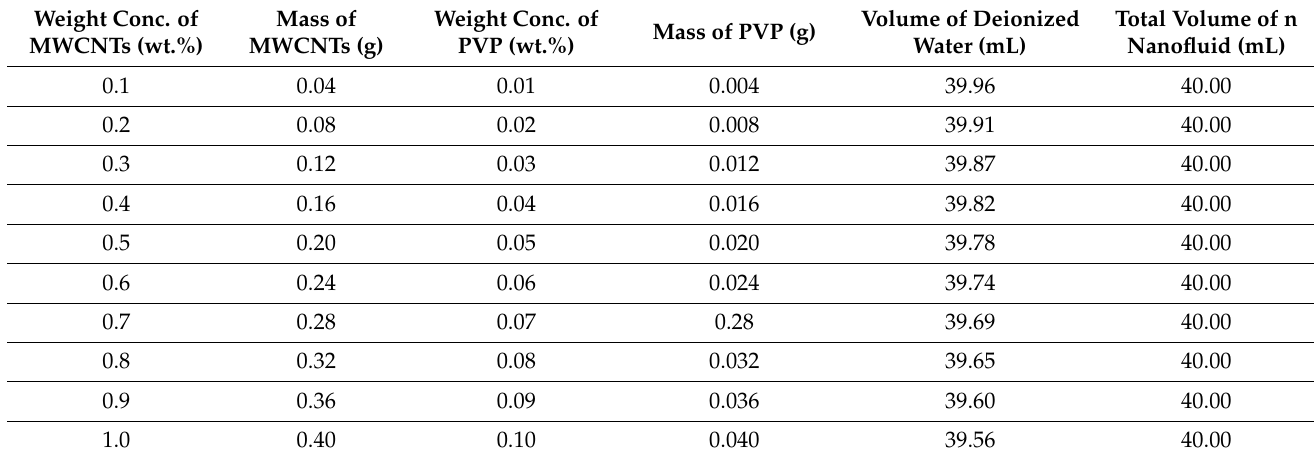
Table 2. Nanofluids formulation using commercial and modified MWCNTs with PVP.